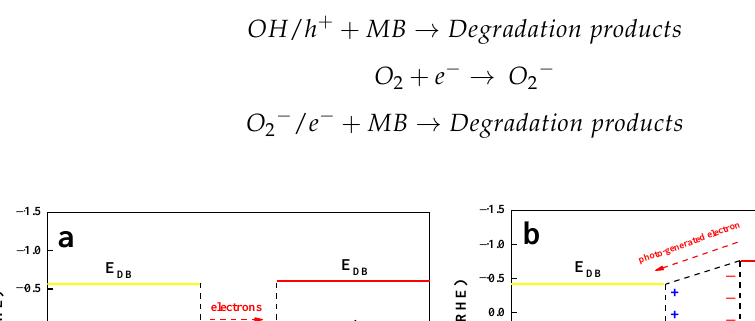
Figure 12. The band gap structure of original ZCS and CSO ( a ), and a composite of ZCS and CSO ( b ).